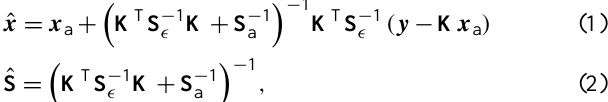
Fig. 3. Monthly a priori emissions for CH shown in Fig. 1. Note the different y -scales.